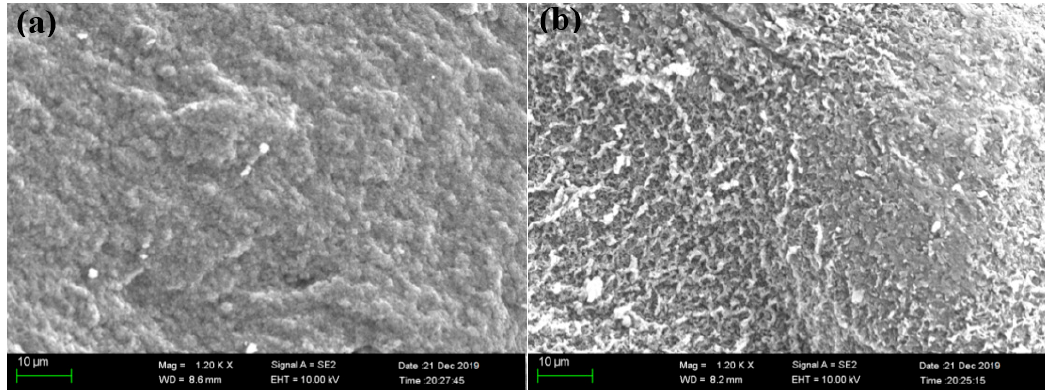
Figure 3. Scanning electron microscopy (SEM) images of ( a ) Ct-PAC and ( b ) Ct-PAC-HDA beads.